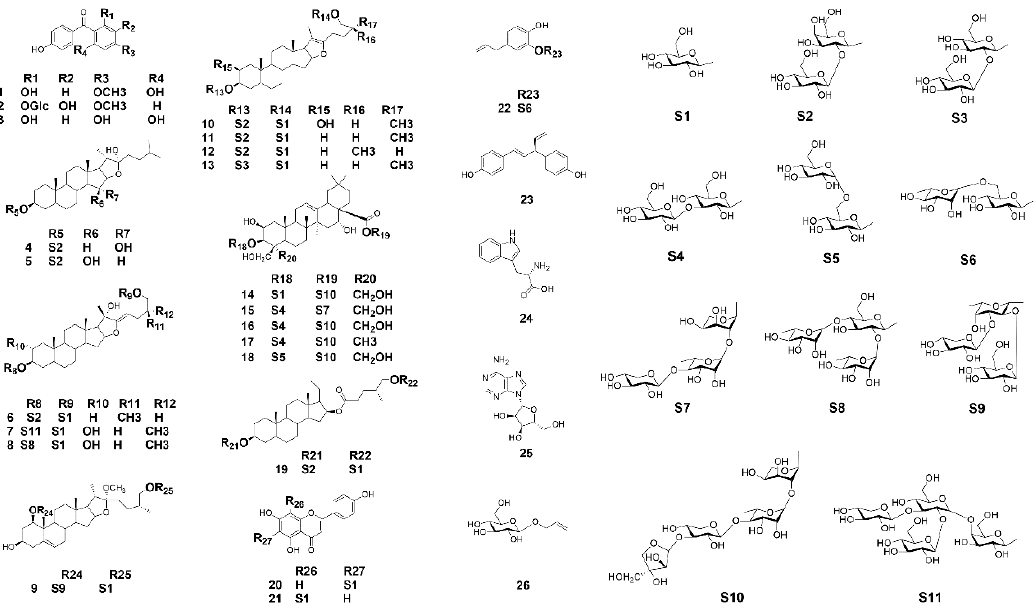
Figure 1. Structures of the isolated compounds from A. asphodeloides.